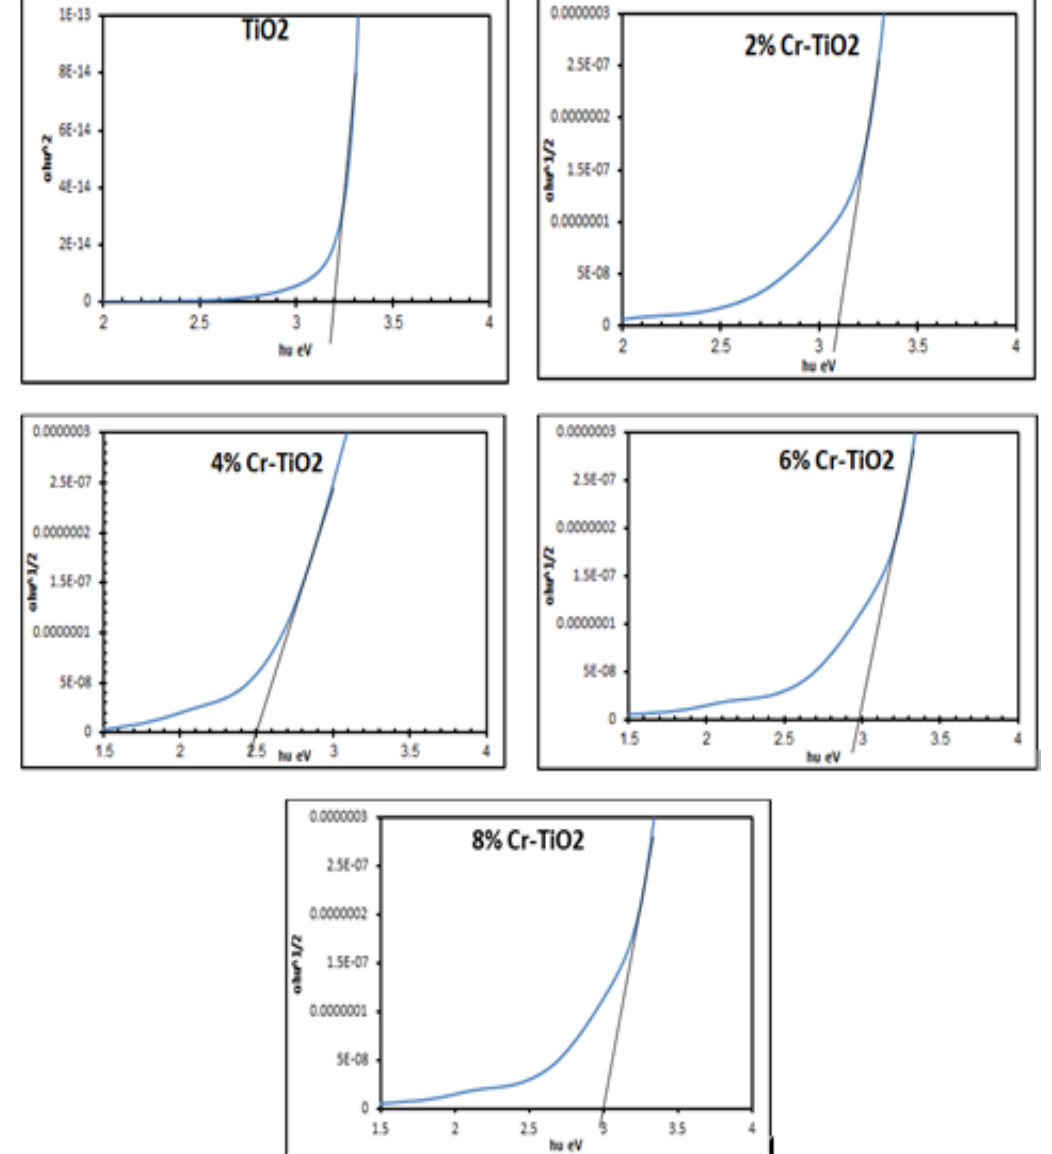
Fig.2: Band energy gap for all